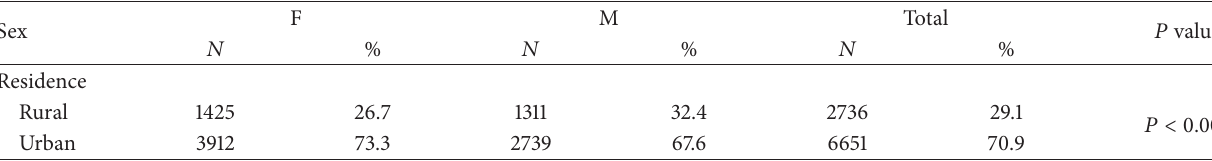
Table 1: Patients participation according to sex and residence.